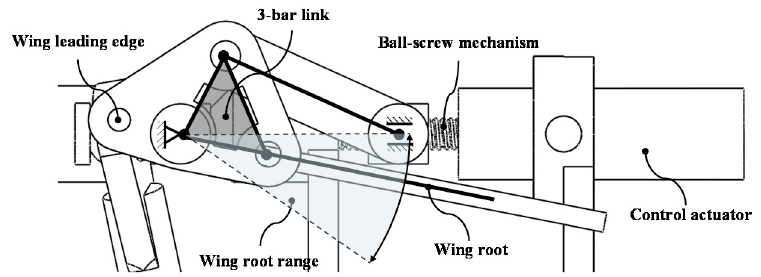
Figure 5. Slide-crank mechanism with three-bar link.